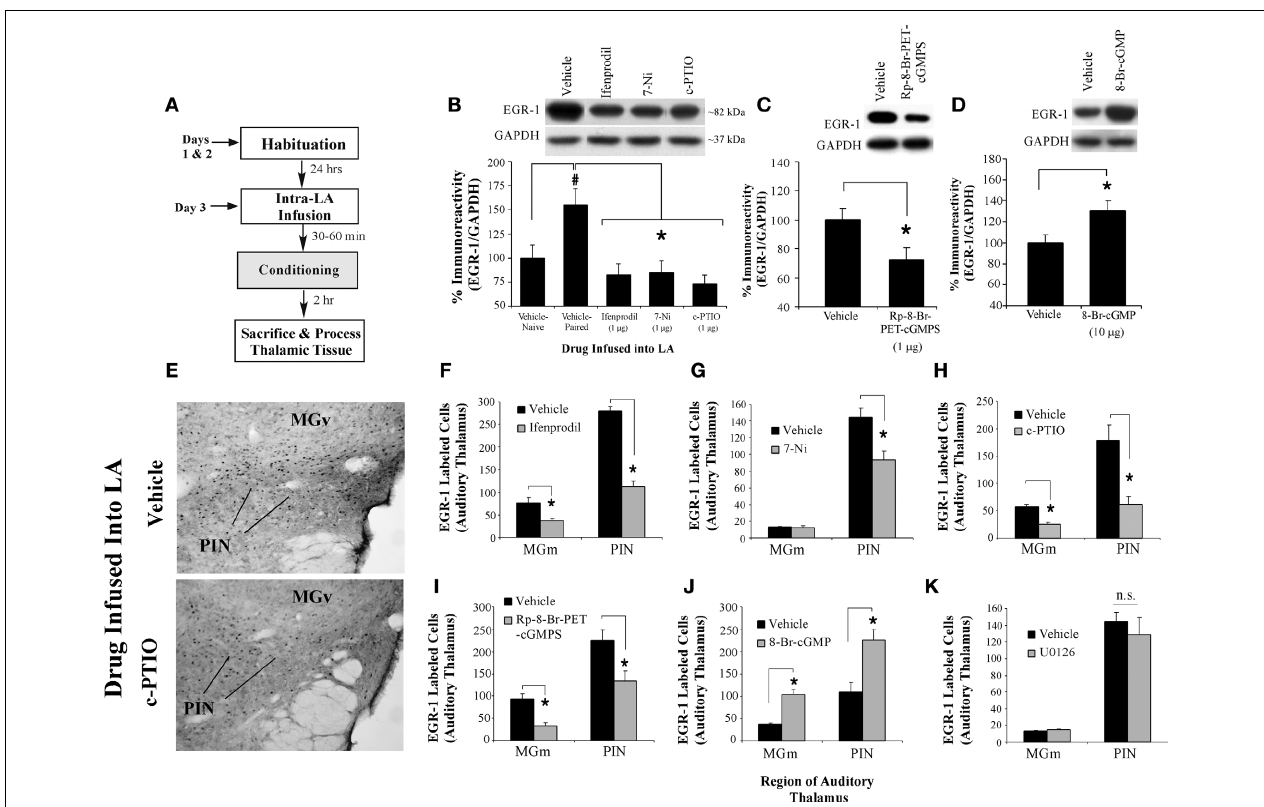
FIGURE 3 | NMDAR-driven synaptic plasticity and NO signaling in the LA regulate training-induced EGR-1 expression in the MGm/PIN. (A) Schematic of the behavioral protocol. (B) Western blot analysis of EGR-1 protein in the MGm/PIN of rats given intra-LA infusion of vehicle ( n = 8), ifenprodil ( n = 8), 7-Ni ( n = 7), or c-PTIO ( n = 8). Representative blots can be seen in the inset. * p < 0.05 relative to the vehicle group. (C) Western blot analysis of EGR-1 protein in the MGm/PIN of rats given intra-LA infusion of vehicle ( n = 9) or Rp-8- Br-PET-cGMPS ( n = 13). Representative blots can be seen in the inset. * p < 0.05 relative to the vehicle group. (D) Western blot analysis of EGR-1 protein in the MGm/PIN of rats given intra-LA infusion of vehicle ( n = 14) or 8-Br-cGMP ( n = 14). Representative blots can be seen in the inset. * p < 0.05 relative to the vehicle group. (E) Representative 20X photomicrographs of